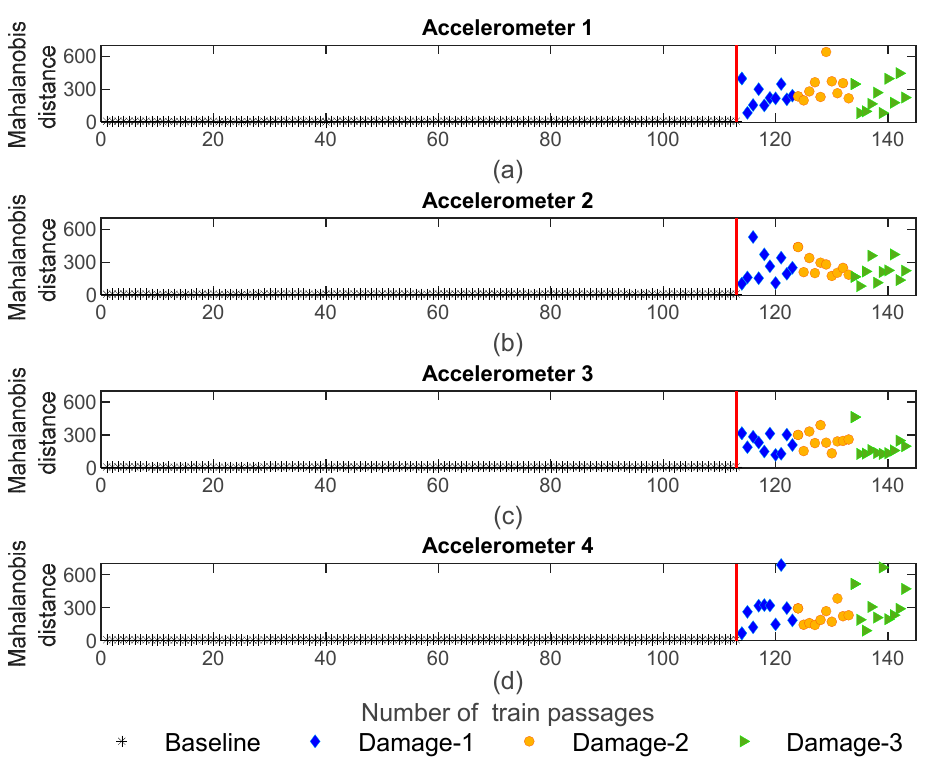
Figure 18. CWT—data fusion for all 143 baseline and damage scenarios: ( a ) MD for accelerometer 1, ( b ) MD for accelerometer 2, ( c ) MD for accelerometer 3, ( d ) MD for accelerometer 4.